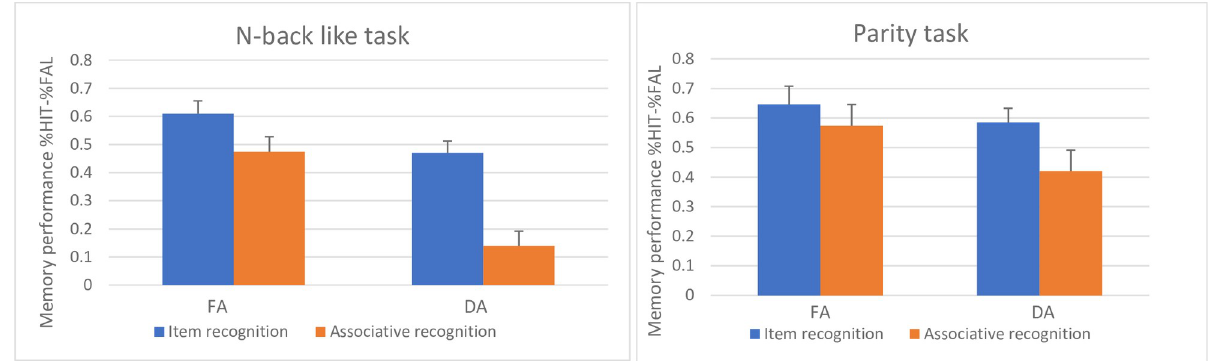
Fig 2. Memory performance in Experiment 1; proportion of hits minus false alarms (FAL) in full- (FA) and divided-attention (DA) conditions for the two experimental groups. The error bars represent standard error of the mean.